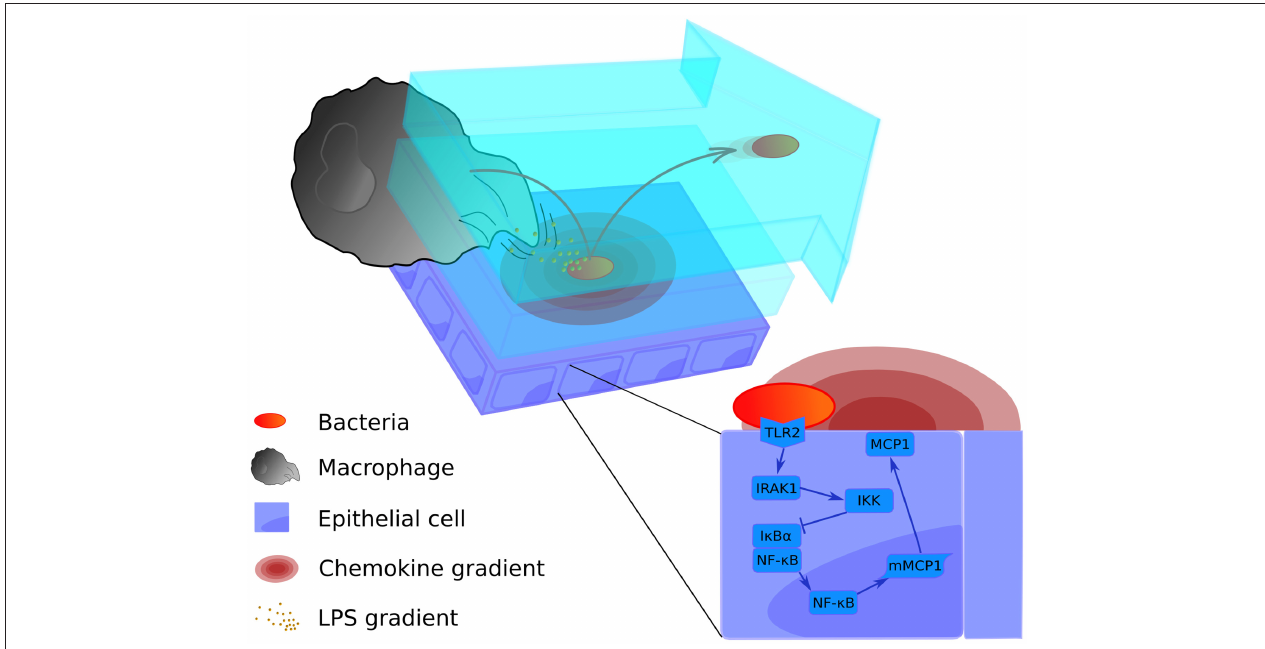
FIGURE 1 | Graphical representation of the multi-level mathematical model of bacterial lung infection. The upper left panel displays processes at the tissue level of the model. It incorporates two lining fluid layers between which bacteria can transition (light blue layers). In both layers, the bacterial cell wall sheds factors (small orange particles) that attract nearby macrophages. In addition, when bacteria (red-orange oval) are attached to the epithelial cell layer (purple rectangles), they trigger the release of chemokine (pink concentric ovals) from the host epithelial cells; these chemokines act as a secondary attractive stimulus to macrophages (large gray structure). Bacteria can transition to the upper flowing layer (arrow-shaped blue layer), where they are moved by the flow toward the alveolar opening, and back again to the lower layer to re-attach at another site. The bottom right panel displays the intracellular level, containing the signaling pathway of the epithelial cells